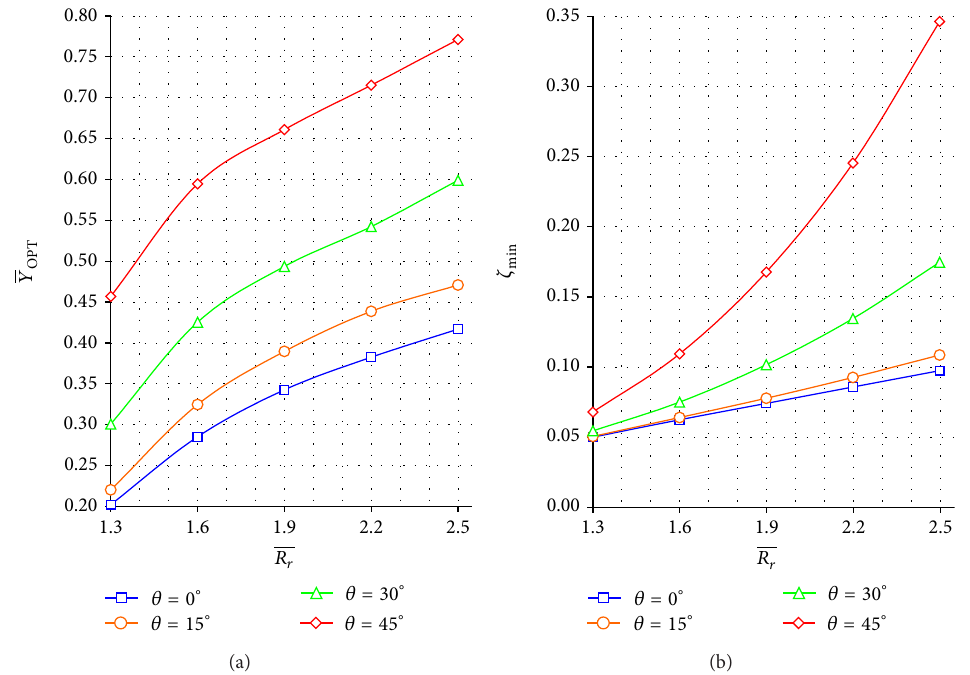
Figure 12: Charts of the optimal slope (a) and minimum losses 𝜁 , (b) for wide ranges of 𝑅 𝑟 and 𝛼 .